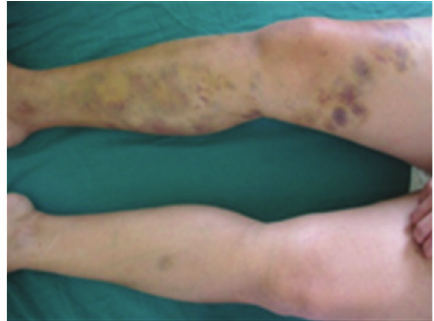
Figure 1: Unilateral ecchymoses.